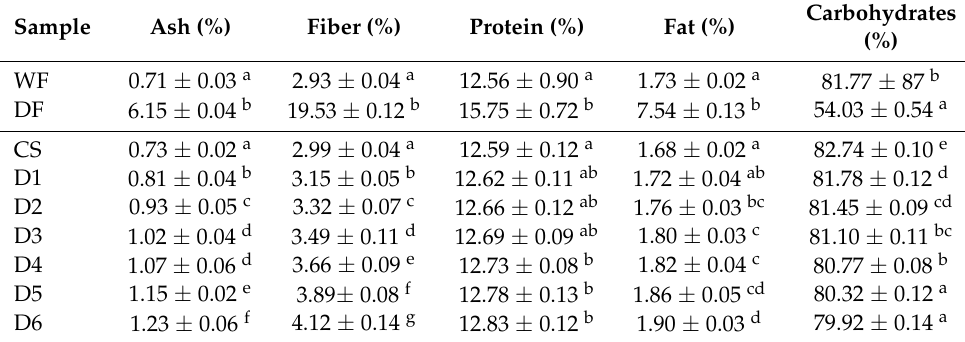
Table 1. Basic chemical composition of WF, DF and bread (%